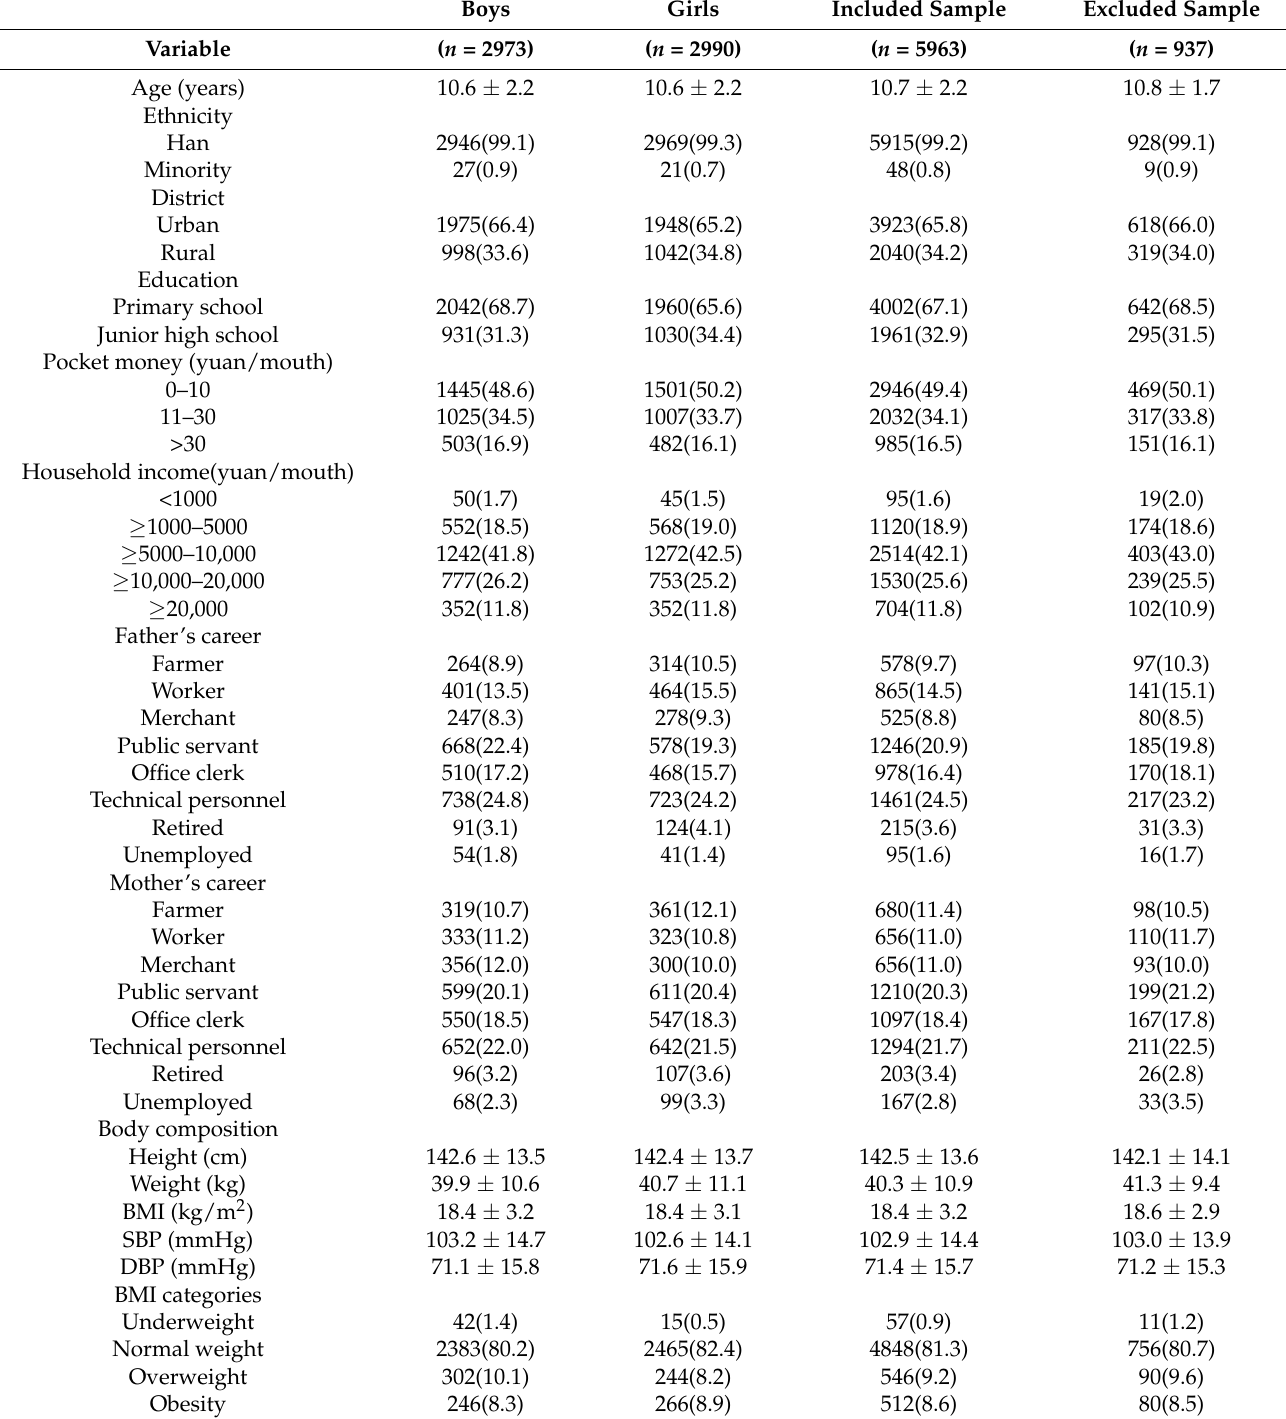
Table 1. Participants’ baseline